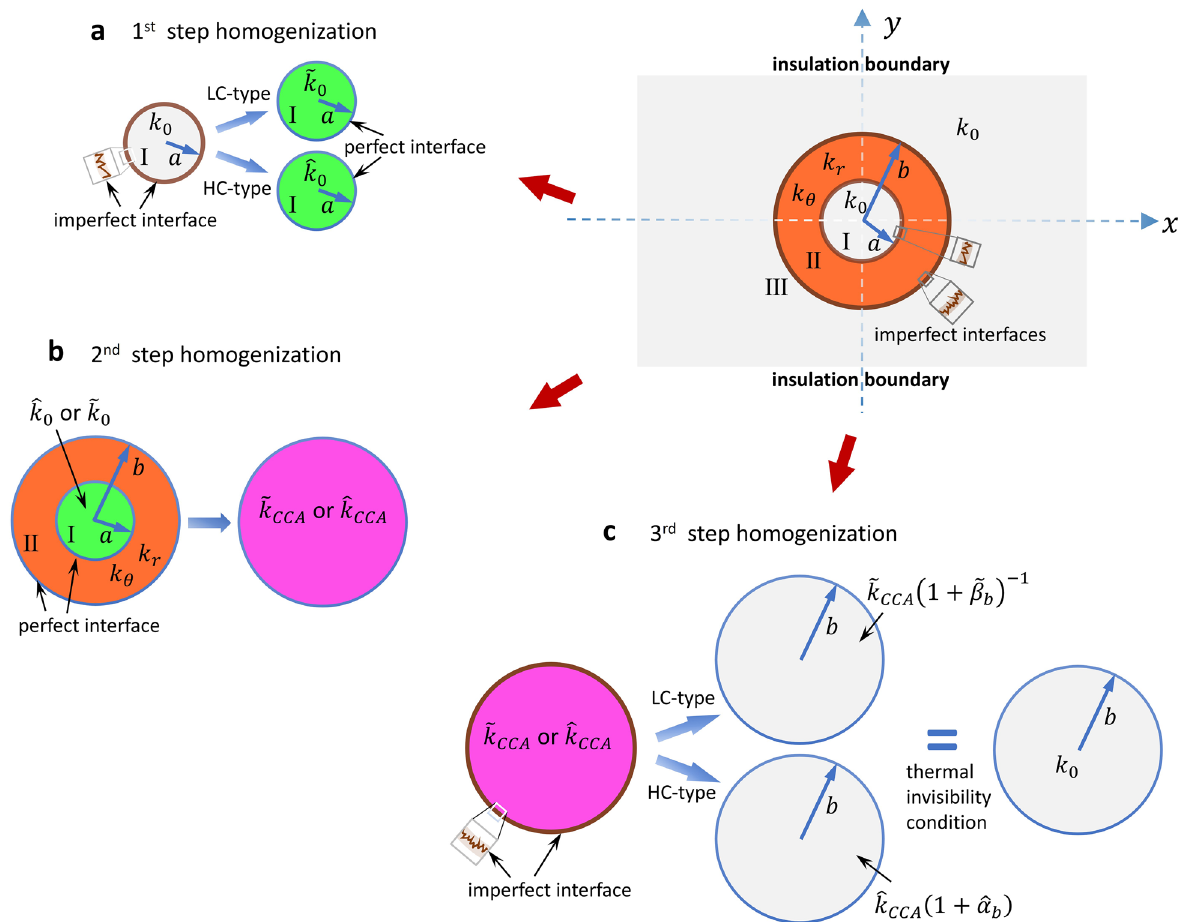
˜ k ˆ k 0 or 0 ˜ k ˆ k CCA or CCA . The final step is to